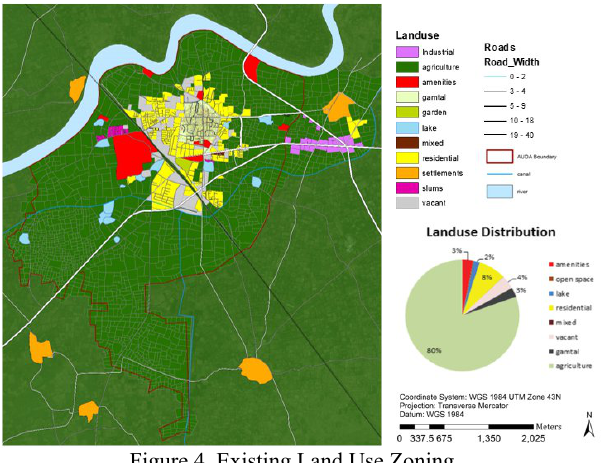
Figure 4. Existing Land Use